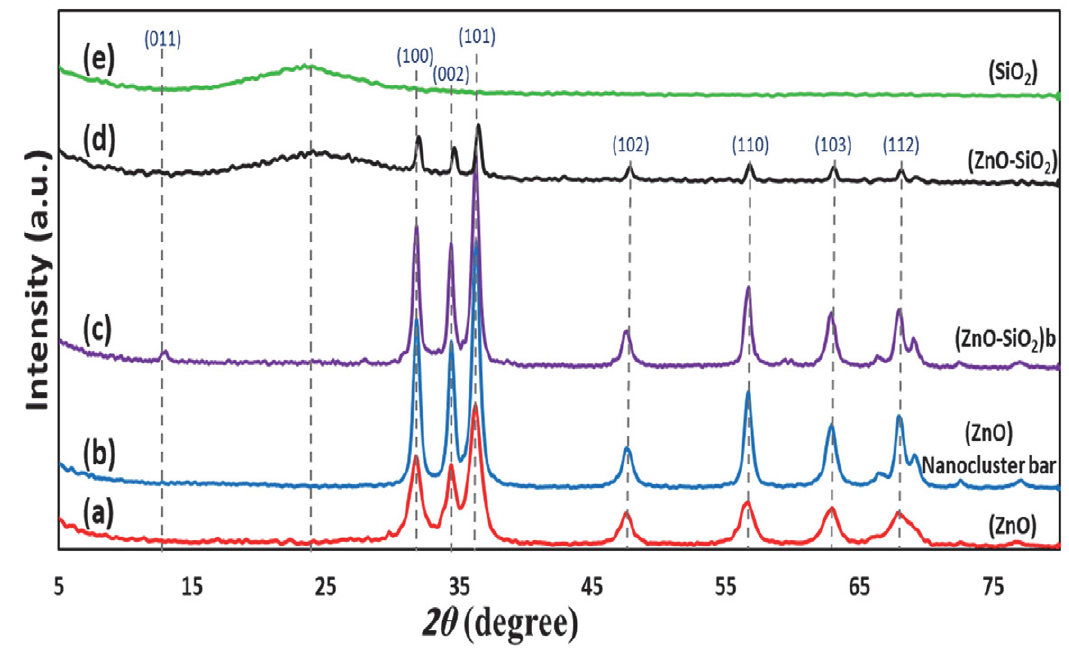
Figure 2: XRD patterns of (a) ZnO NPs, (b) ZnO NC bars, (c) ZnO-SiO 2A (d) ZnO-SiO 2B , and (e) SiO 2 NPs,